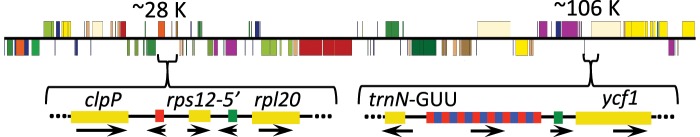
—Plastome repeats in Medicago suffruticosa. Repeats identified in M. suffruticosa suggests repeat-mediated phenomena in a common ancestor of the clade that includes this species and Medicago minima may have been involved in initiation of the novel IR in Medicago minima. The upper portion of the diagram shows the M. suffruticosa unit genome map, below are the regions of interest. Thick black lines represent double stranded DNA. Colored boxes in the plastome map (above) represent gene sequences and colored by functional groups. Values above the map indicate the loci of regions of interest (below). Bracketed regions of interest contain genes (yellow) and repeats (red, blue, and green). Arrows indicate the strand for each coding region and repeat.